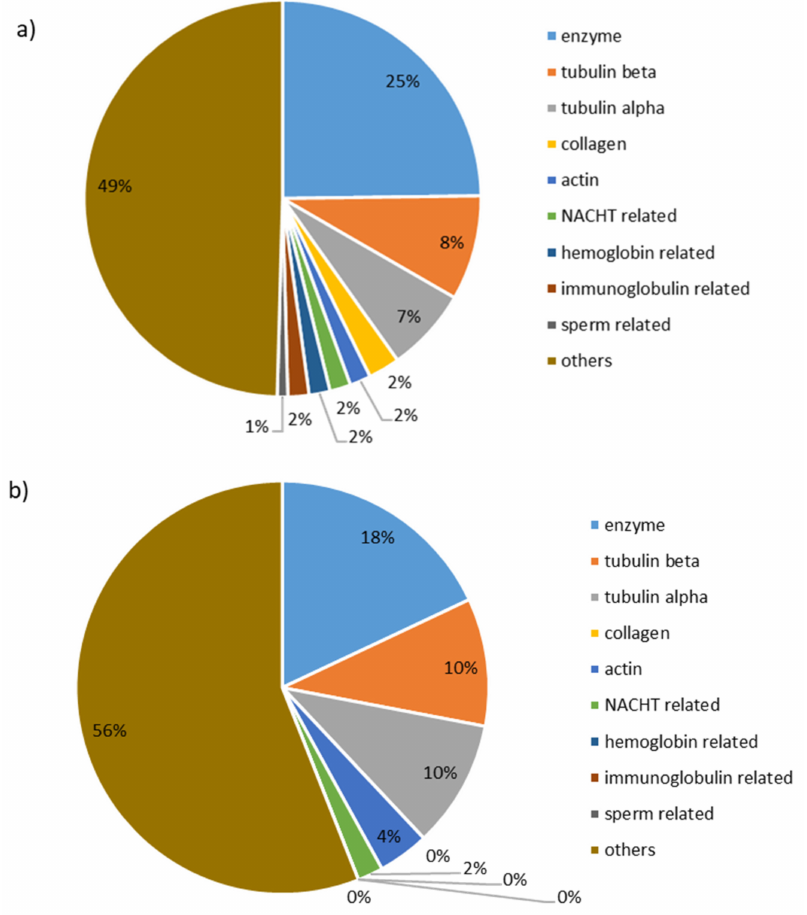
Figure 5. Origin identifications, by UPLC-MS/MS, of peptide sequences recovered after EDUF of herring milt hydrolysate in ( a ) anionic recovery compartment (A − RC) and ( b ) cationic recovery compartment (C +